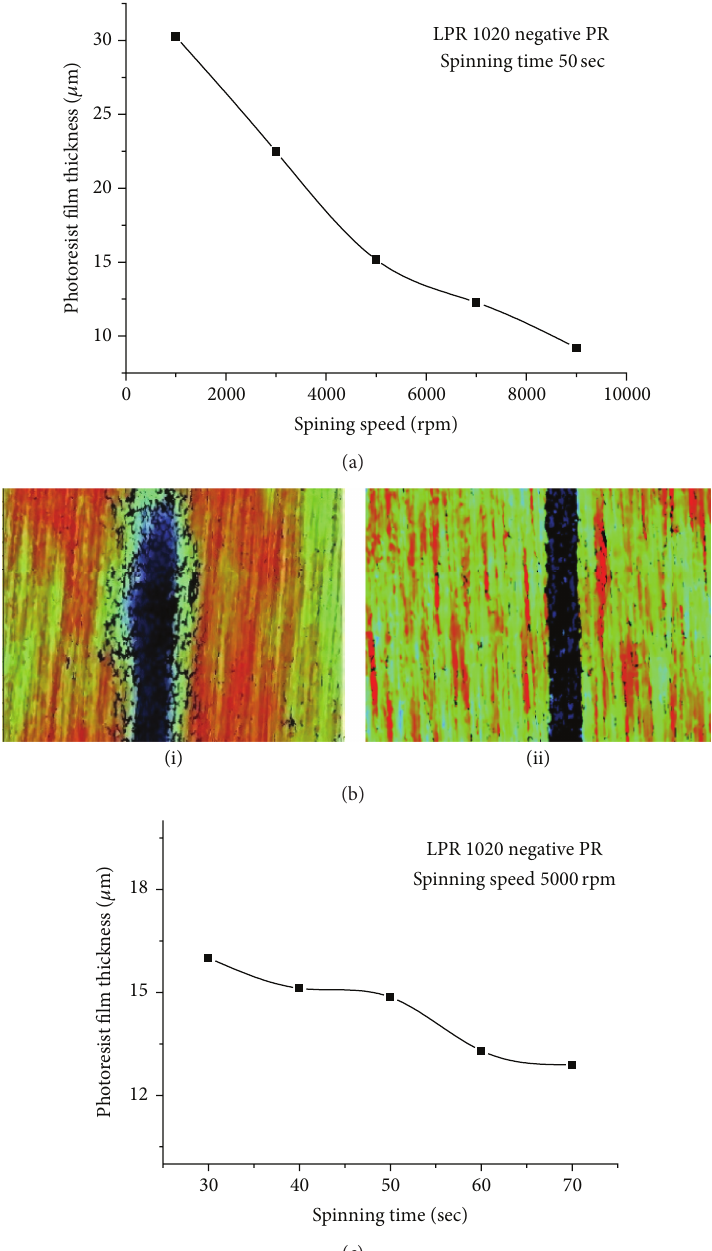
Figure 3: (a) Effect of spinning speed on photoresist film thickness for a spinning time of 50 s. (b) Effect of photoresist coating on etching of micro channels. (i) Substrate with photoresist film thickness of 9.20 𝜇 m; (ii) substrate with photoresist film thickness of 15.16 𝜇 m. (c) Effect of spinning time on photoresist film thickness for a spinning speed of 5000